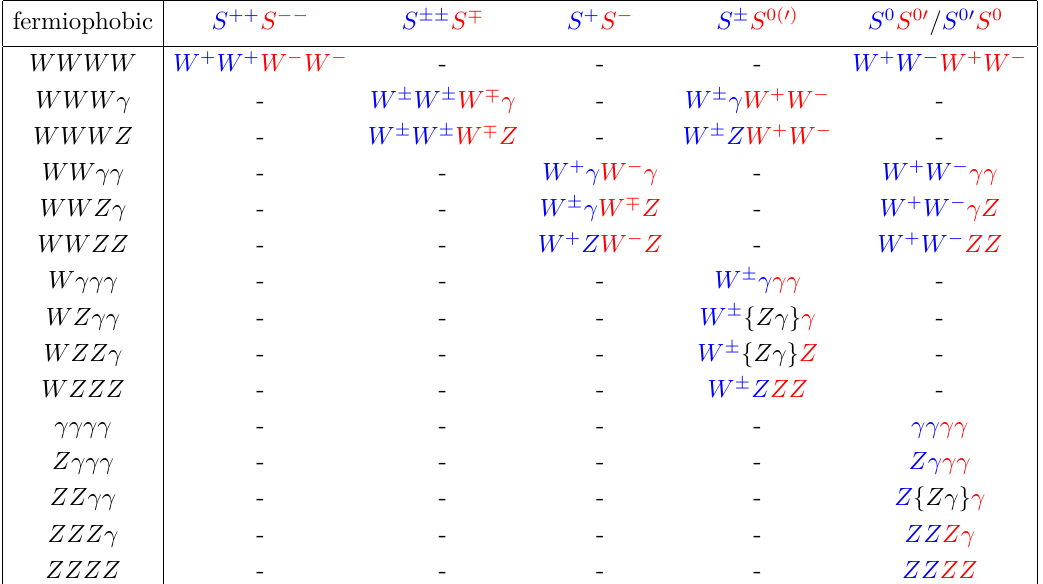
Table 1. Classification of the 24 di-scalar channels in terms of the 5 pair production cases (columns) and the 15 combinations of gauge bosons (rows) from decays. In the channels, the first two and second two bosons are resonantly produced. The notation { Zγ } = Zγ + γZ indicates the two permutations. Charge-conjugated states belong to the same di-scalar